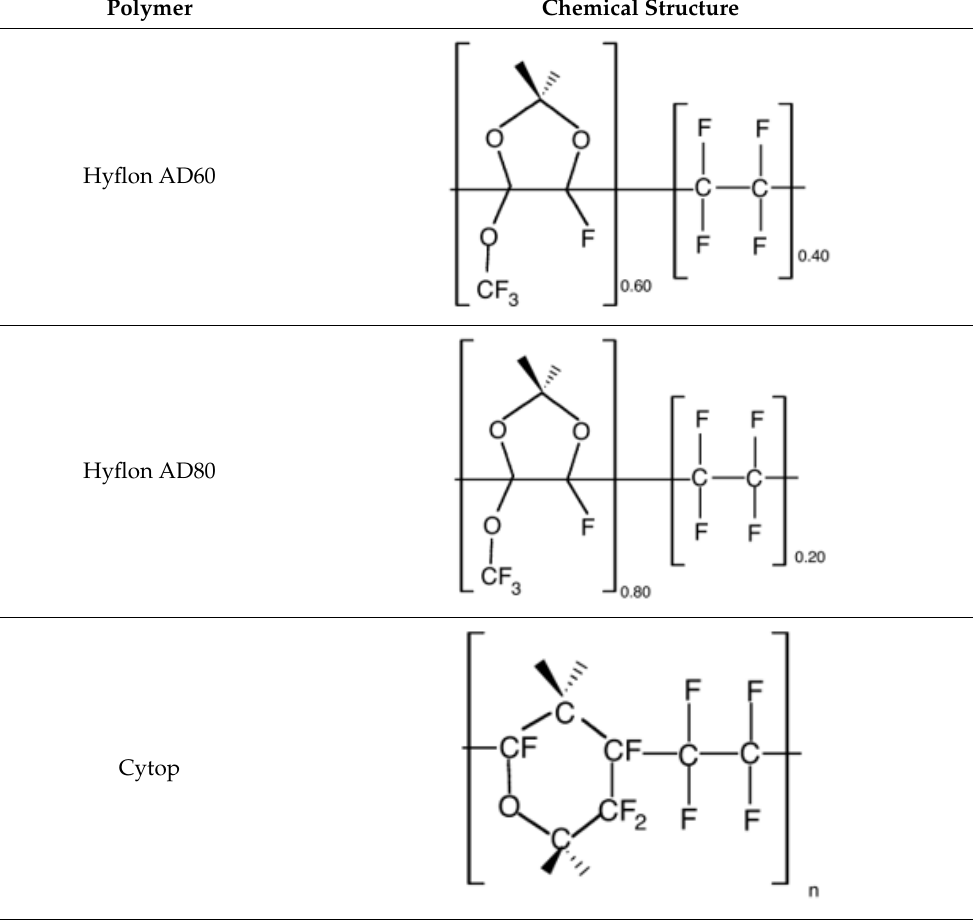
Figure 16. N 2 /CH 4 separation performance for TR polymers ( ● ), PIMs ( ■ ), Perfluoropolymers ( ◆ ) [23]. Table 7. Chemical structure of Selected Perfluoropolymers-Based Membranes.